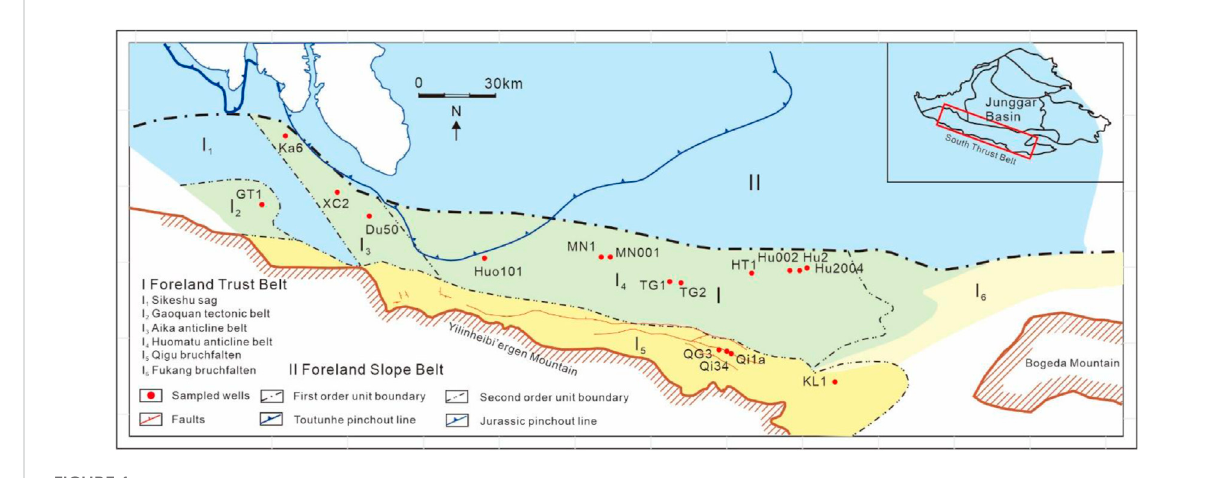
FIGURE 1 Map showing the structural units of STB and the location of sampled